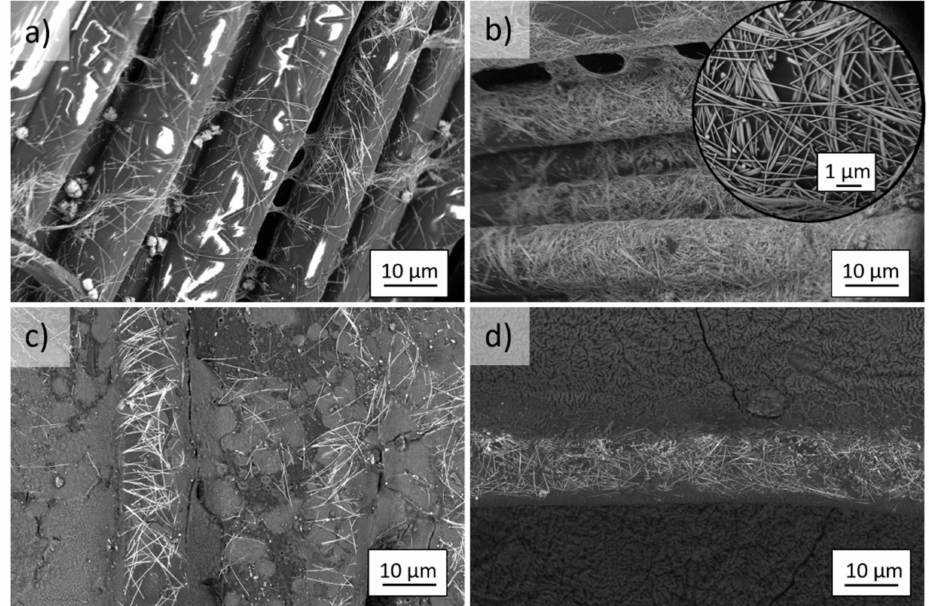
Figure 6. SEM images of modified p Ar fibers after the ( a ) 1-fold and ( b ) 5-fold application of AgNWs and the ( c ) mixture Ag+S, and ( d ) layer-by-layer Ag/S modification (magnification of 2500 × and 20,000 ×